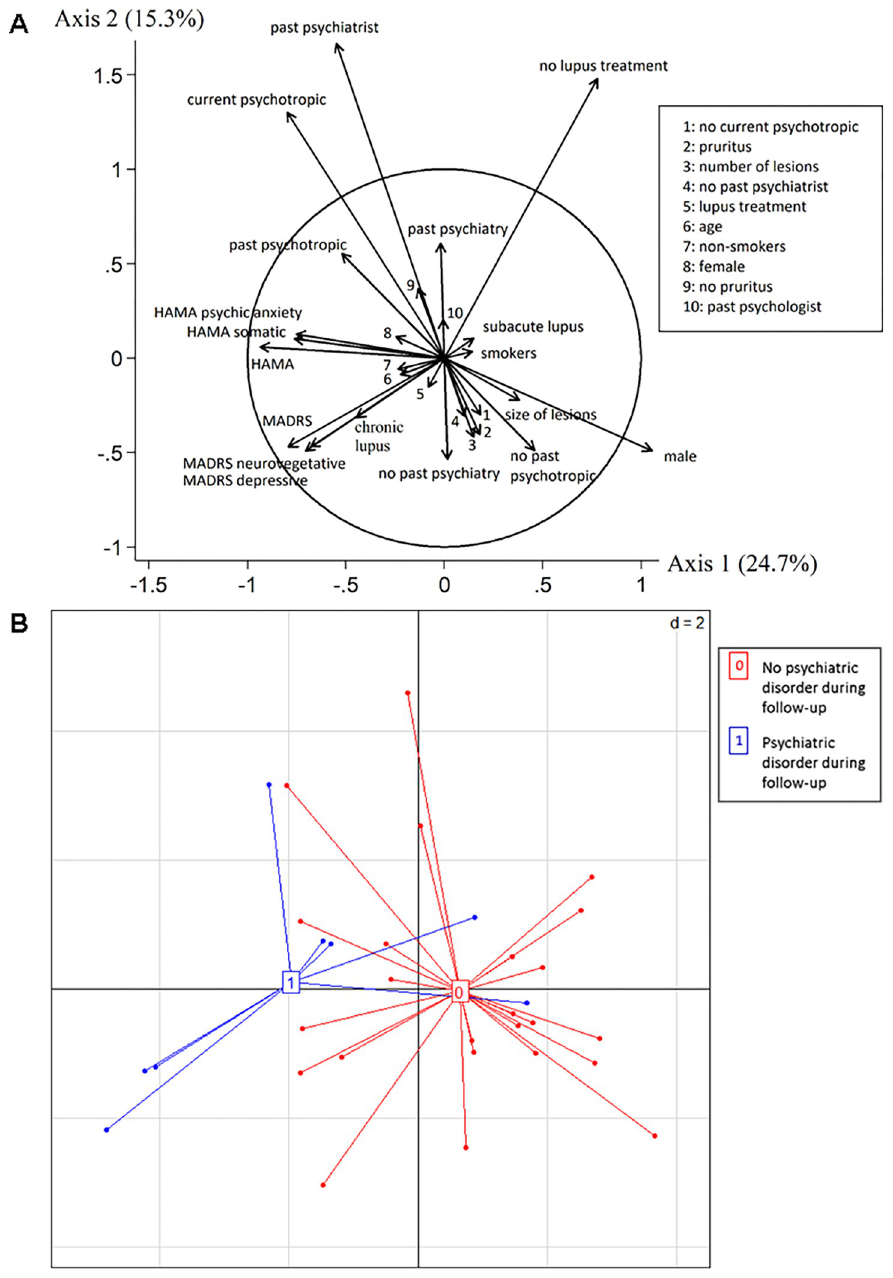
Fig 2. Baseline profile of patients who developed a psychiatric disorder during the 2-years follow-up. A: Correlation circles obtained with factor analysis showed the correlation between the variables. The shorter vectors represented variables with weak correlations and less contribution to the axis (axis 1 = 24.7% of the variance and axis 2 = 15.3%). B: Patients representation (one point for each patient) showing 2 clusters: one with psychiatric disorder during follow-up (1, blue) and another without psychiatric disorder (0, red). The variables most involved in these two clusters were all HAMA scores.